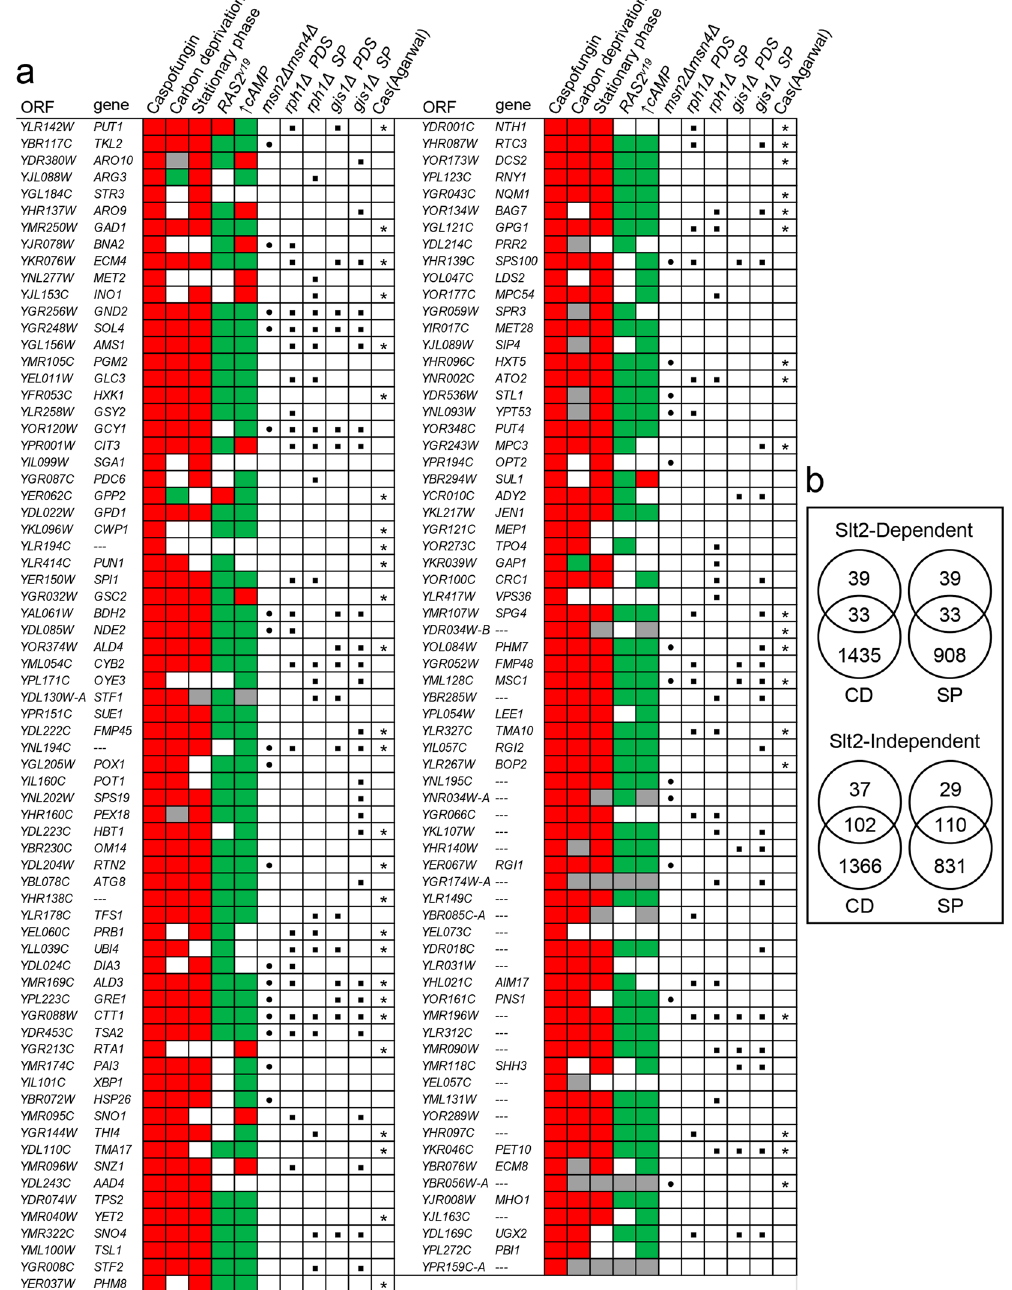
Figure 2. The genes induced by caspofungin independently of Slt2 are targets of the cAMP/PKA pathway. ( a ) Open reading frames whose transcripts were induced at least twofold in experiments of DNA microarrays in the wild-type BY4741 strain, independently of Slt2, after 2 h of CAS treatment, are shown and compared to different transcriptional genome-wide datasets using the MEV (Multiexperiment Viewer) Version 4.9 software from TIGR 67 : Carbon deprivation (YNB lacking D-glucose for 2 h) 68 , stationary phase (YPD medium for 2 days) 20 , RAS2 val19 (cells expressing a constitutively active allele of RAS2 ) (taken from GEO database GSE8805), and high levels of cAMP (medium including 1 mM cAMP) 69 . Green and red boxes indicate those genes repressed and induced at least twofold respectively in each condition. Gray boxes denote missing values. Those genes that were found to be dependent on Msn2/Msn4 for activation by CAS from DNA microarrays are labeled with a black dot. Black squares indicate those genes previously reported to be dependent on Rph1 and Gis1 transcription factors after diauxic shift (PDS) (wild-type strain grown in glucose depletion for 9 h) and/or stationary phase (SP) (wild-type strain grown in YPD for 3 days) 29 . Those genes previously described upregulated in the study of Agarwal et al . 12 are marked with an asterisk. ( b ) Comparison of the overlap of Slt2-dependent or independent genes with those induced by stationary phase (SP) or carbon deprivation